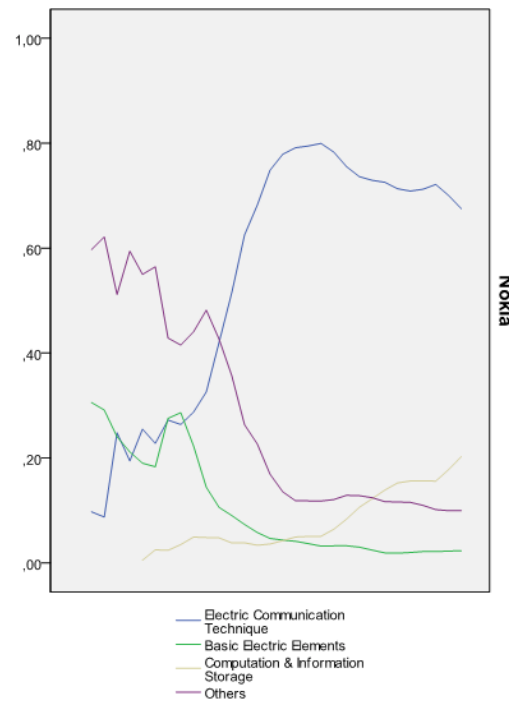
Fig. 3. Timeline of Nokia’s patenting